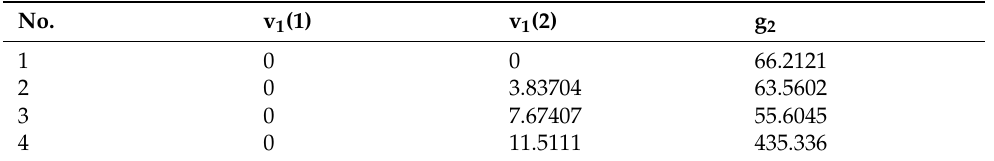
Table 3. Strategies of the first influence agent under fixed strategies of the Principal and the second